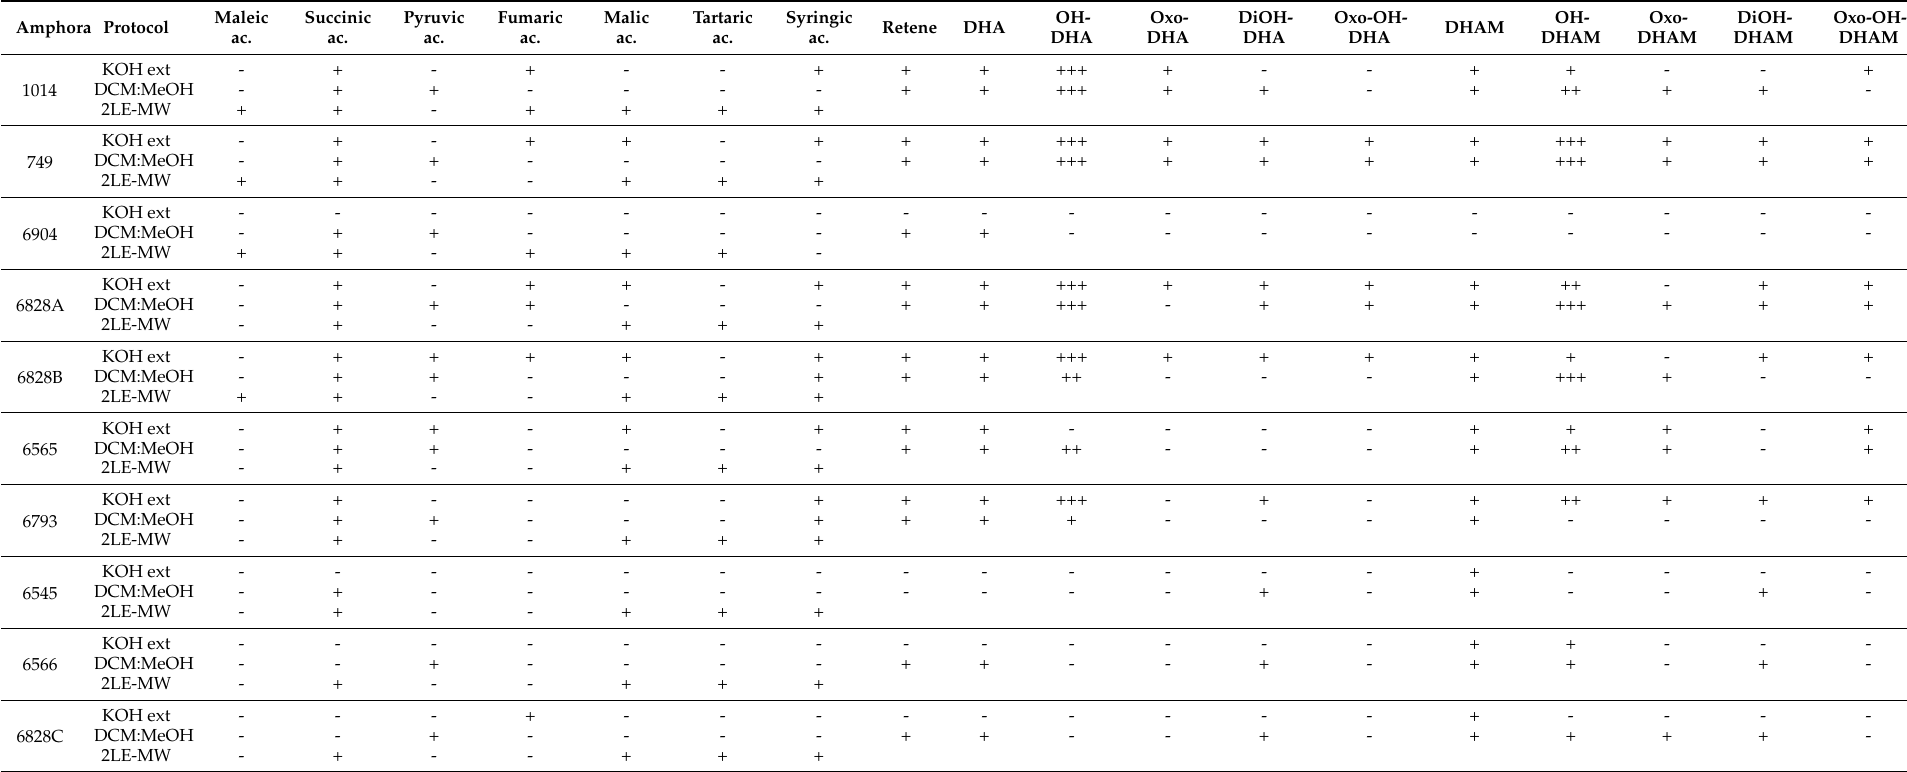
Table 2. Molecules identified in shards. Presence (+) and absence (-) of molecular markers under alkaline fusion (KOH ext.), organic extraction with DCM:MeOH, butylation applied on the remaining fraction (2LE-MW). The number of ‘+’ refers to the number of molecules present. ac.: acid; OH-DHA: hydroxy-DHA (i.e., 3-hydroxy-DHA; 7-hydroxy-DHA and 15-hydroxy-DHA); Oxo-DHA: 7-oxo-DHA; DiOH-DHA: 7,15-dihydroxy-DHA; Oxo-OH-DHA: 7-oxo-15-hydroxy-DHA. DHAM and oxidized derivatives (OH-DHAM, Oxo-DHAM, DiOH-DHAM and Oxo-OH-DHAM) refer to the same skeleton with methyl ester derivatives instead of the carboxylic acid function. Amphora